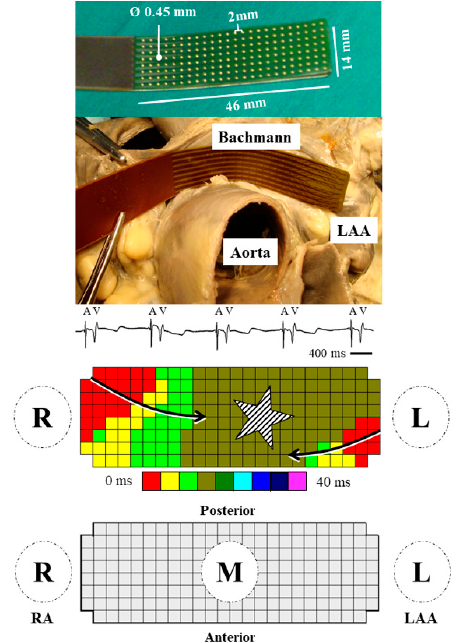
Figure 1. Mapping procedure of Bachmann’s bundle. ( Upper panel) 192-unipolar electrode mapping array including measurements of length, inter-electrode distance and electrode diameter. The mapping array is subsequently positioned at Bachmann’s bundle, by placing the array behind the aorta with the tip against the left atrial appendage. ( Middle panel ) unipolar electrogram with steep atrial deflection (A) and far-field ventricular signal (V). After marking all atrial deflections, a color-coded activation map is constructed. The arrows depict direction of wavefront propagation. The striped star illustrates an area of simultaneous excitation / focal wave. In the current example, the mid-entry corresponds to location of the interatrial septum and transition of BB to left atrial roof (posterior). ( Lower panel ) Schematic overview of 192-unipolar electrode mapping array. Entry sites are denoted with R (right), M (middle) and L (left). IAS = interatrial septum; LAA = left atrial appendage; RA = right